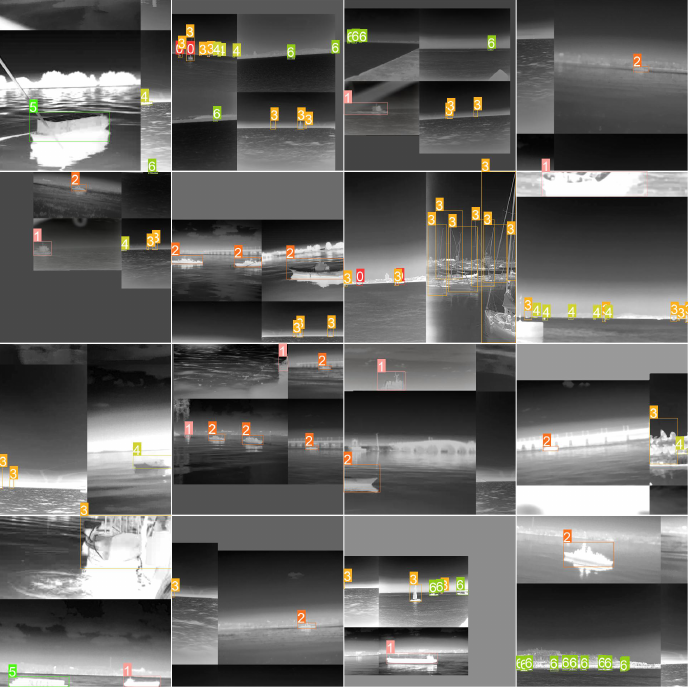
Figure 9. Mosaic data augmentation method. 0–6 denotes Liner, Bulk carrier, Warship, Sailboat, Canoe, Container ship, and Fishing boat,